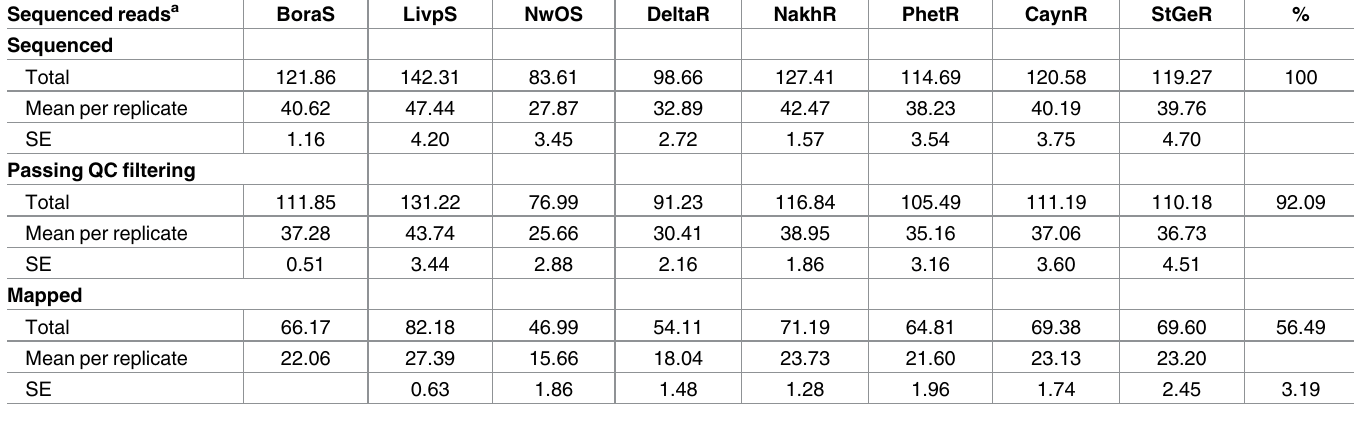
Table 2. Sequencing and mapping